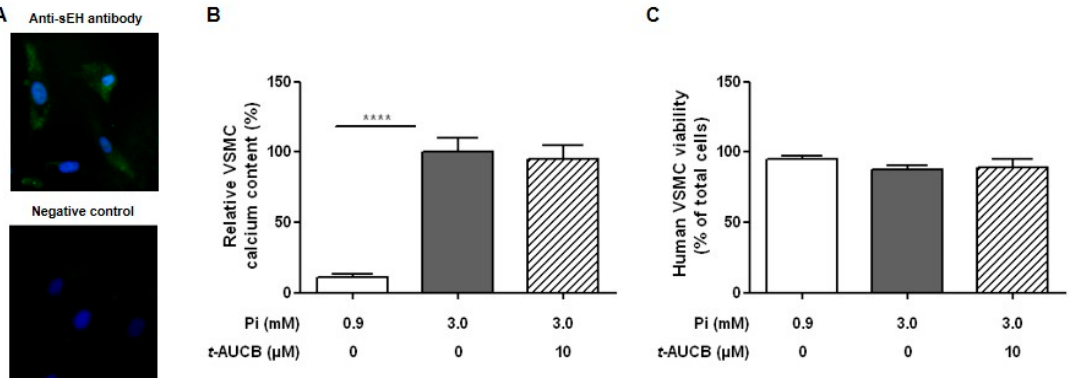
Figure 4. Representative images of sEH immunostaining in human vascular smooth muscle cells (VSMCs) ( A ): Relative calcium content (( B ) n = 5–9 per group) and trypan blue viability assay (( C ) n = 7–13 per group) of human VSMCs cultured in normal (0.9 mM inorganic phosphate, Pi) and high-phosphate (3.0 mM Pi) conditions for 14 days in the absence and in the presence of 10 µM t -AUCB. **** p < 0.0001.